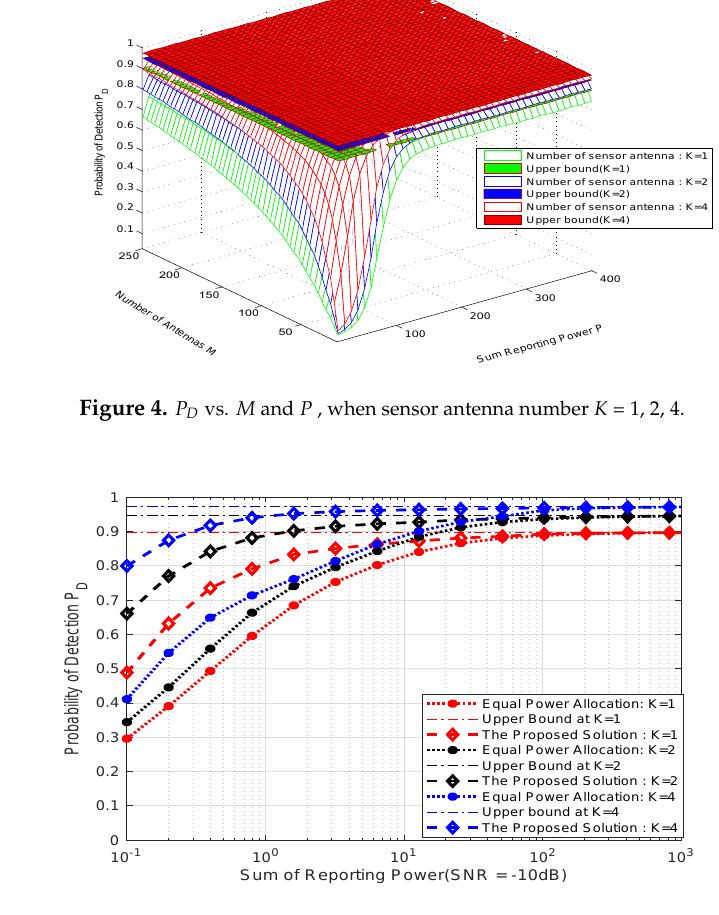
Figure 5. P D vs. P for comparison of different methods of detection